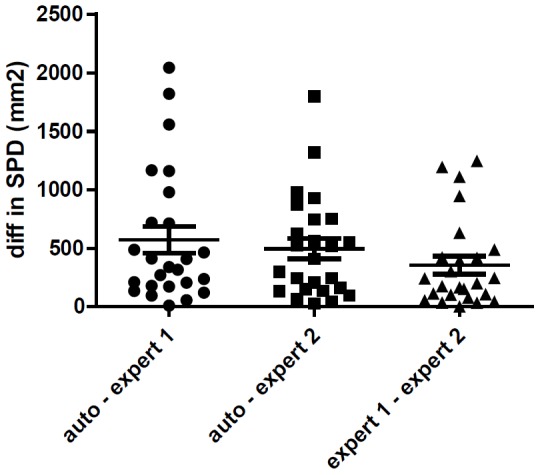
Comparison of the difference in 2- dimensional measurements of two expert raters and the diameters extracted from the automatic segmentations on the study population of 25 patients.SPD =  sum of products of diameters in mm2. Wide horizontal bars indicate the mean and the shorter horizontal bars indicate the SD.